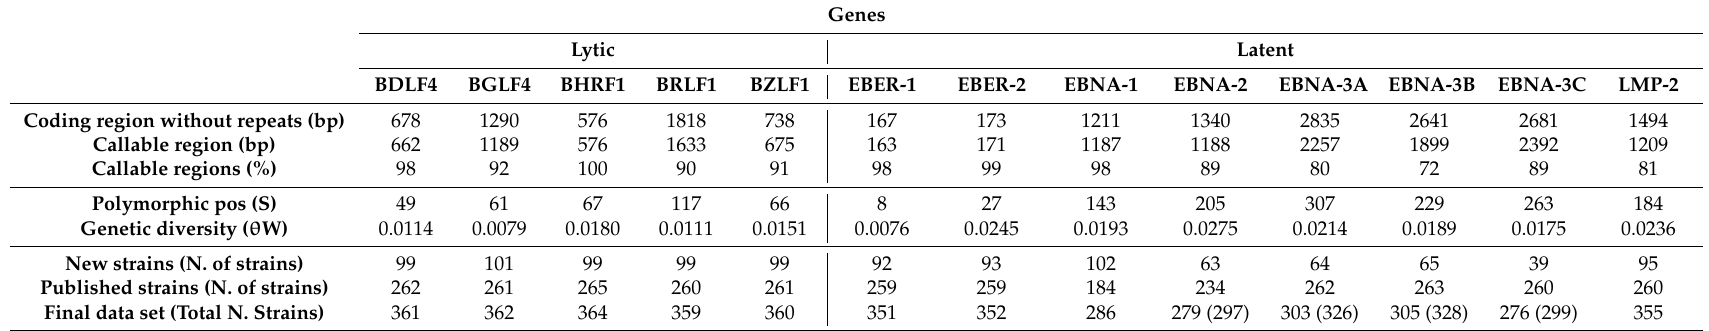
Table 2. Variability in the data set. Summary of variability indexes, sample numbers (type1 in brackets), and callable region lengths per gene. Genetic diversity ( θ w) was estimated using the Watterson’s